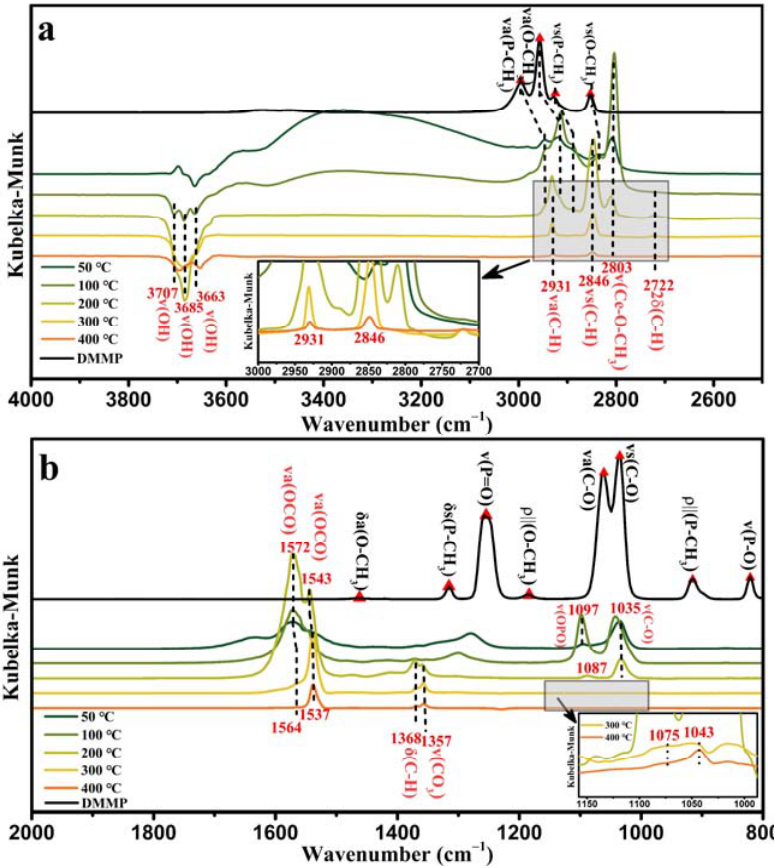
Figure 14. In situ DRIFTS spectra of CeO 2 at varying temperatures in ( a ) the high-frequency region and ( b ) in the mid–low frequency region, the inset is a magnified image of the tagged area.